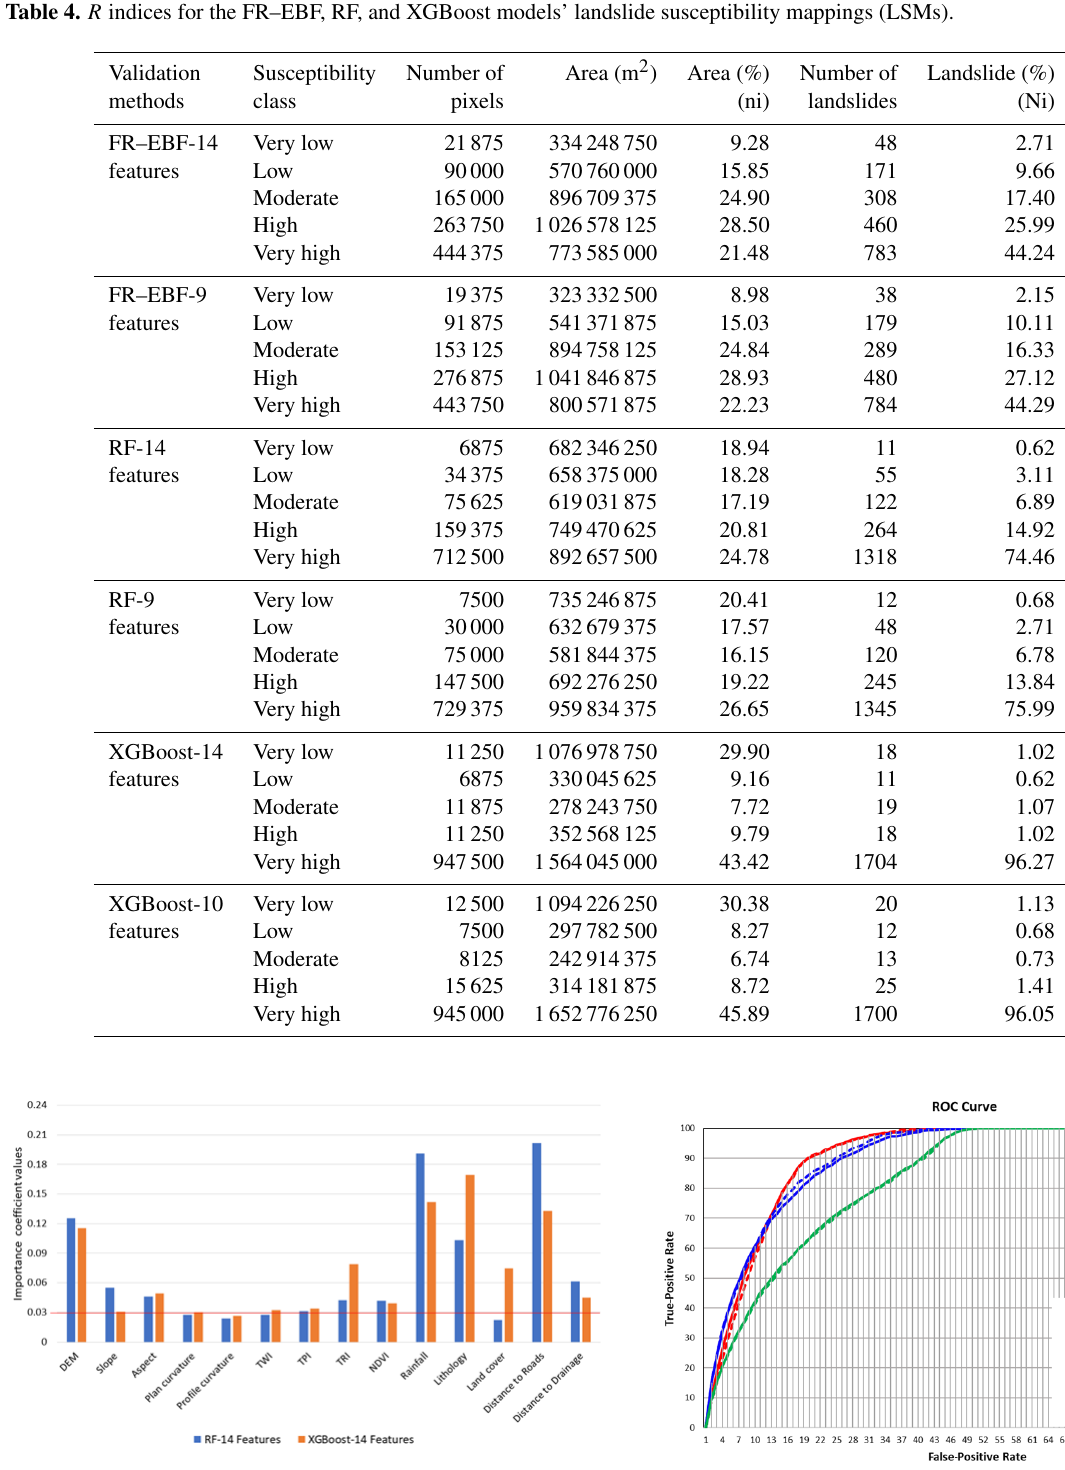
Figure 11. Testing for the performance of the statistical and ma- chine learning models for LSM in the province of Belluno,